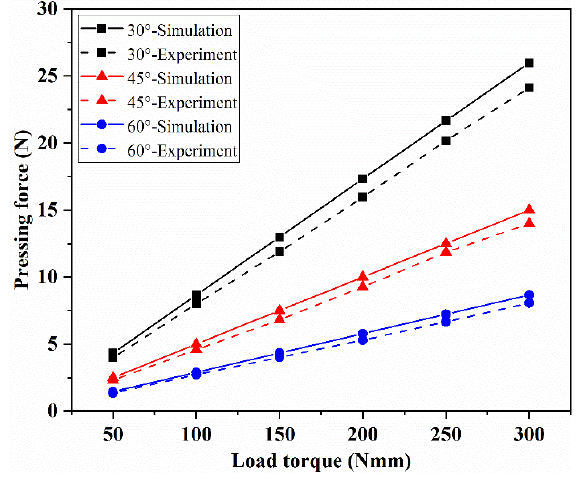
Figure 23. The influence of cone angle on the pressing force.